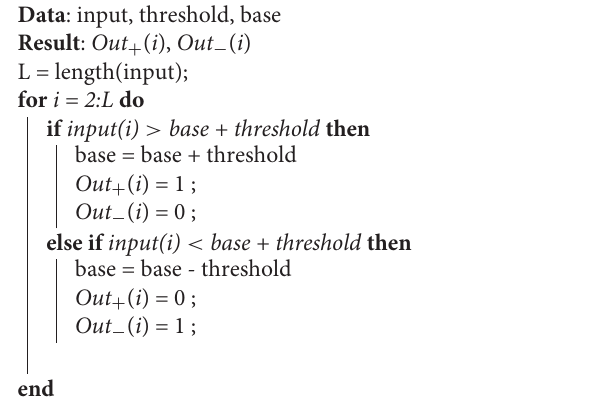
Algorithm 1: Modified step forward encoding algorithm.